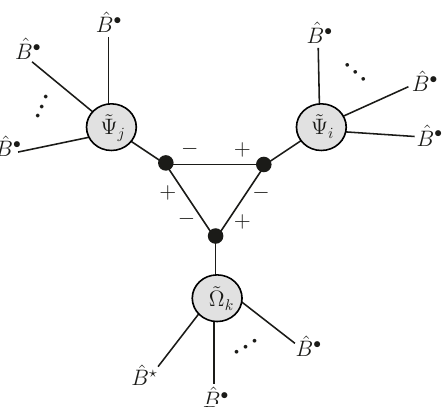
Figure 4 . Expansion of the Yang-Mills fields in the B fields in the loop terms of the effective action generates tree-level connections encoded in the field transformation